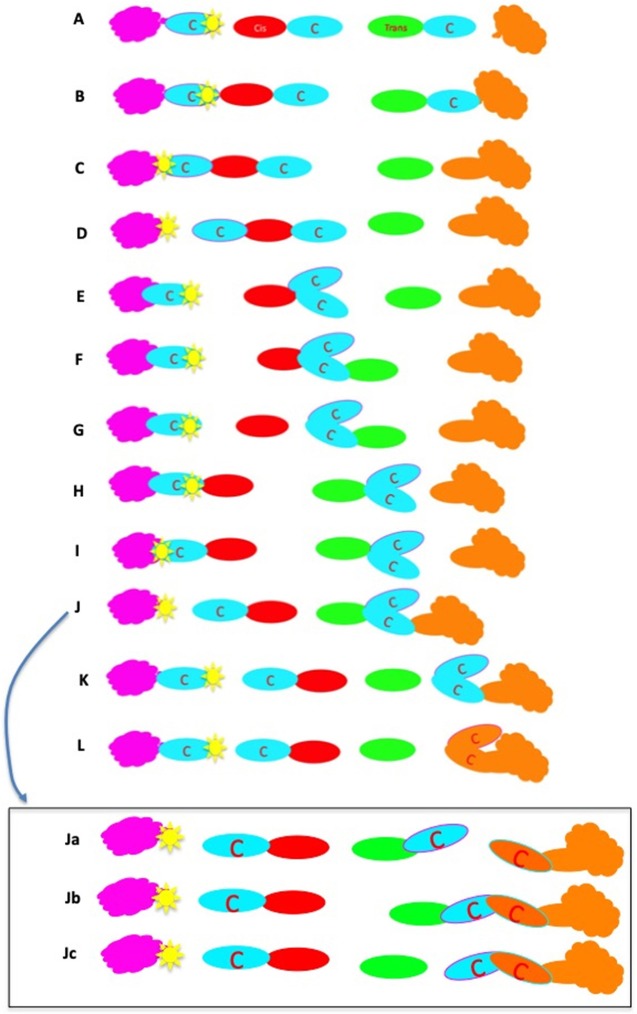
Scheme of intra-Golgi transport in S. cerevisiaewithin the framework of the KARM. This scheme ensures maturation and progression of cargo domains. According to the main postulate of the KARM, to become separated, it is necessary to have initial fusion. Thus, fusion is the first event, and then fission (at another site) is the second event. The ER is magenta; artificial cargo is blue and indicated with the letter “C”; the cis-Golgi compartment is red; the trans Golgi compartment is green; the post-Golgi compartment is brownish; the exited cargo domain is surrounded with a red line. The situation that is shown here was formed after several rounds of cargo domain detachment from ERES, when most of the Golgi compartments already contain the artificial cargo. (A) The initial situation when most of the Golgi compartments contain cargo domains (blue). (B) Fusion of the cis-Golgi compartment (red) with ERES, and the trans-Golgi compartment (green) with the post-Golgi compartment (brownish). (C) Shift of the COPII coat (yellow) from the cargo domain (blue oval surrounded by a magenta ring). There is fission of the connections between the trans compartment (green) and the cargo domain, which is consumed by the post-Golgi compartment. (D) Detachment of the cis-Golgi compartment connected to two cargo domains from ERES (yellow). (E) Rotation of the cis-Golgi (for the sake of clarity). (F) Fusion between the trans-Golgi compartment and the cis-Golgi compartment connected to cargo domains. (G) Detachment after fission of the cis-Golgi compartment from the trans-Golgi compartment connected to cargo domains. (H) Fusion of the cis-Golgi compartment with ERES, where a new cargo domain covered with Sec31 is prepared. (I) Shift of the Sec31-coat (yellow) from the cargo. (J) Detachment of the cis-Golgi compartment connected with the new cargo domain from ERES, and fusion of the trans-Golgi part connected to cargo domains with the post-Golgi. (K) Detachment of the trans-Golgi compartment from the cargo domains. (L) The final stage when the cargo domain of interest is within the post-Golgi compartment. (Ja–c) The alternative consequence of the final events; namely, the cargo domains connected with the trans-Golgi compartment can be delivered to the post-Golgi one after another.